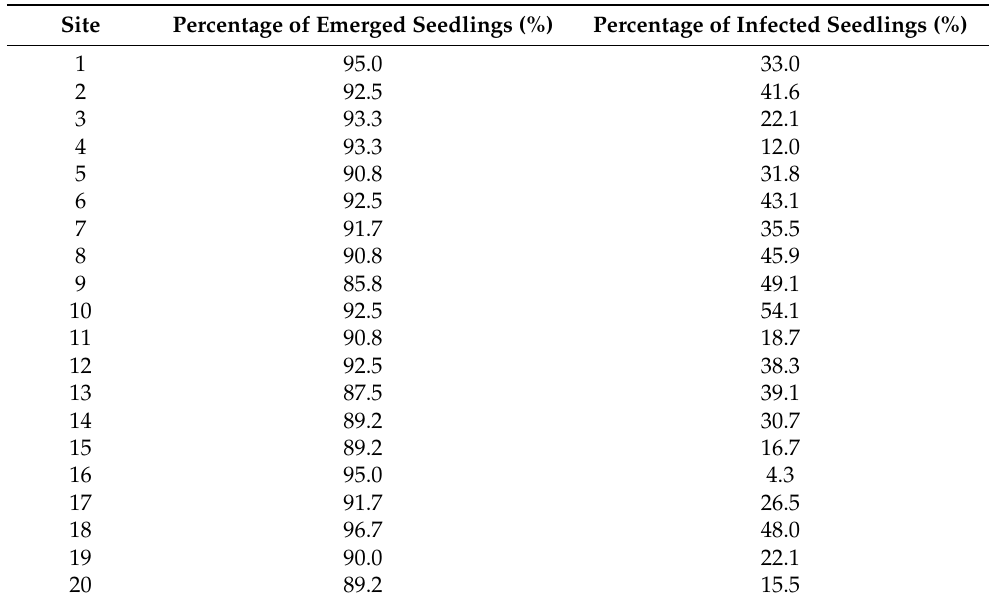
Table 2. Average percentages of emerged GB sunflower line seedlings and infected seedlings on the 20